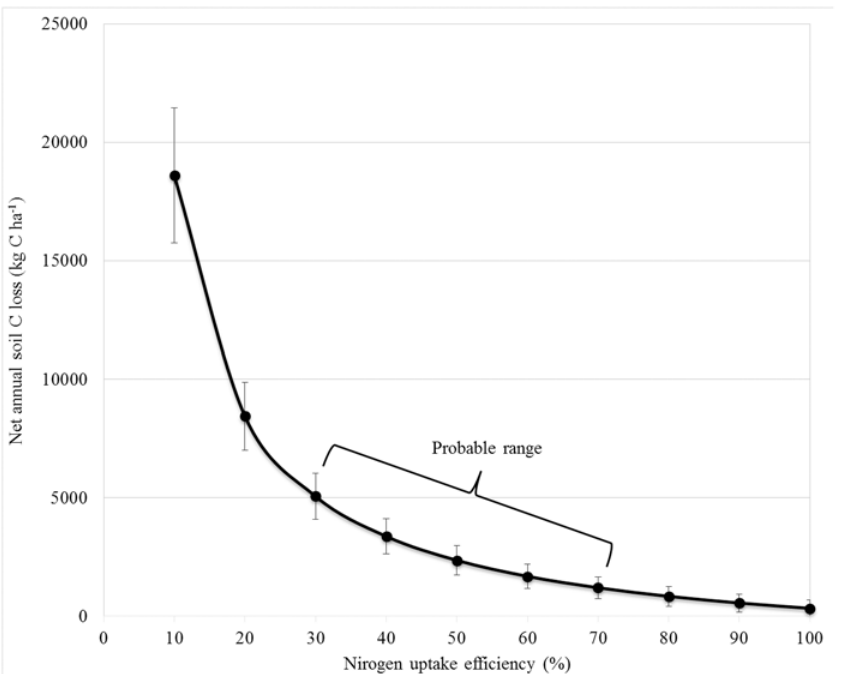
Fig 3. The effect of N uptake efficiency (NUE) assumptions on calculated soil C loss. Error bars are the standard error (n = 8) based on the final output from the soil C loss model, average of both sites, using conventional propagation of error